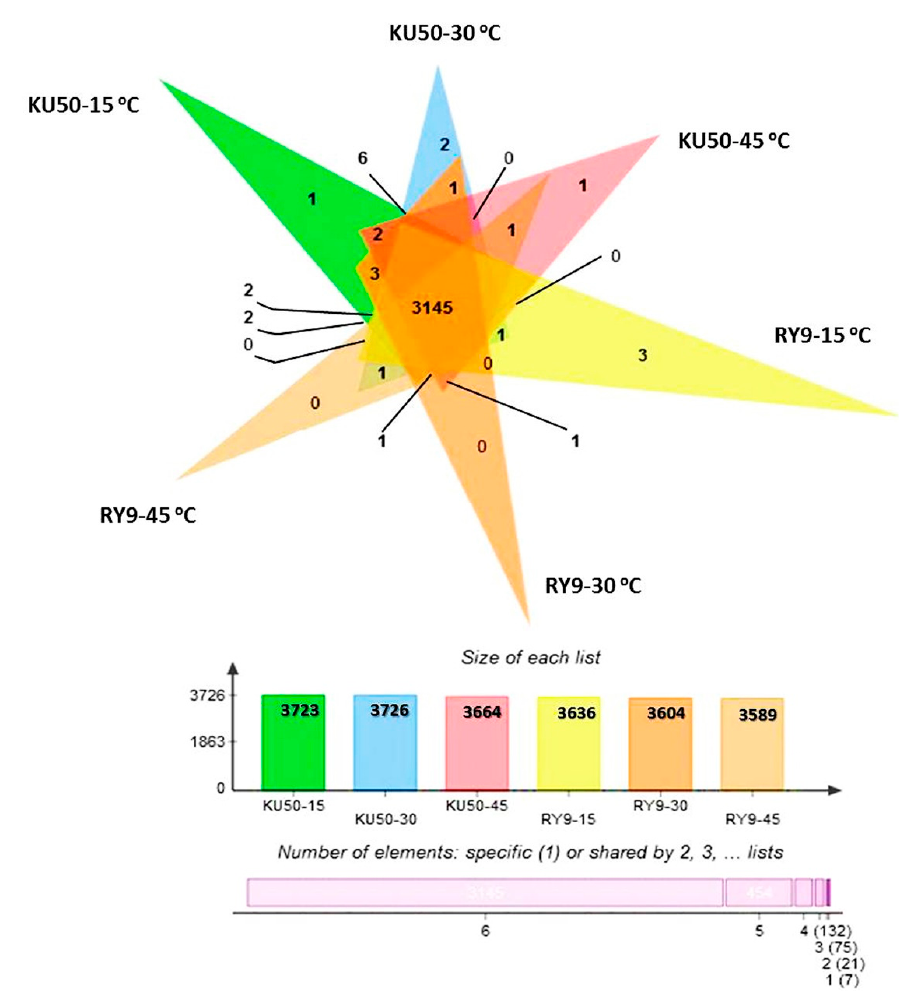
Figure 4. Venn diagram of proteins differentially expressed in leaves of cassava cvs. Kasetsart 50 (KU50) and Rayong 9 (RY9) after exposure to 15, 30, and 45 °C for 60 min in a temperature chamber. The number of expressed proteins in Kasetsart 50 after incubating at 15, 30, and 45 °C for 60 min was 3723, 3726, and 3664, respectively, while 3636, 3604, and 3589 proteins in Rayong 9 leaves were detected after incubating at 15, 30, and 45 °C for 60 min. The protein lists from leaves of Kasetsart 50 and Rayong 9 were input to a Venn diagram and 1 protein was identified as being from KU50 at 15 °C, 2 proteins from KU50 at 30 °C, 1 protein from KU50 at 45 °C, 3 proteins from RY9 at 15 °C, and 3145 proteins from both KU50 and RY9 at 15, 30, and 45 °C. Table 1. The differentially expressed proteins in leaves of cassava cvs. Rayong 9 and Kasetsart 50 exposed to low- (15 °C) and high-temperature (45 °C) stress compared to those at normal tempera- ture (30 °C). Genotype